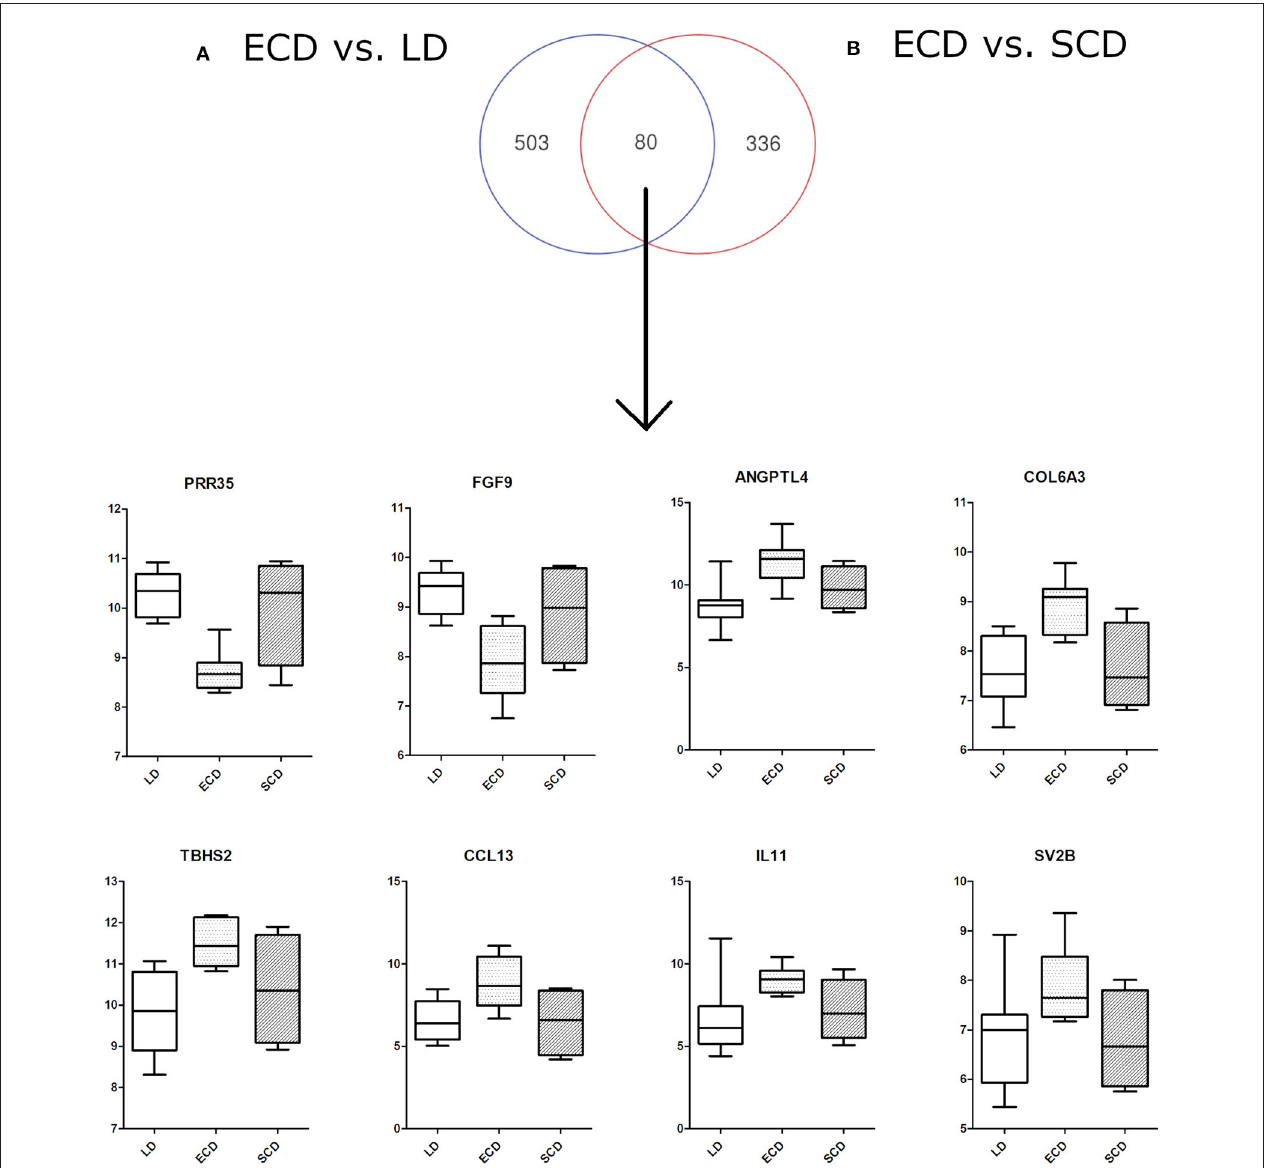
FIGURE 2 | Venn diagram showing overlap of deregulated genes (80 transcripts) for particular comparisons of donor categories: (A) ECD vs. LD (583 deregulated transcripts), (B) ECD vs. SCD (416 deregulated transcripts). The overlap of some genes shows differential expression of ECD compared with SCD and LD. PRR35, proline-rich 35 protein; FGF9, fibroblast growth factor 9; ANGPTL4, angiopoietin-like 4; COL6A3, collagen, type VI, alpha 3; TBHS2, thrombospondin 2; CCL13, chemokine (C-C motif) ligand 13; IL11, interleukin 11; SV2B, synaptic vesicle glycoprotein 2B.